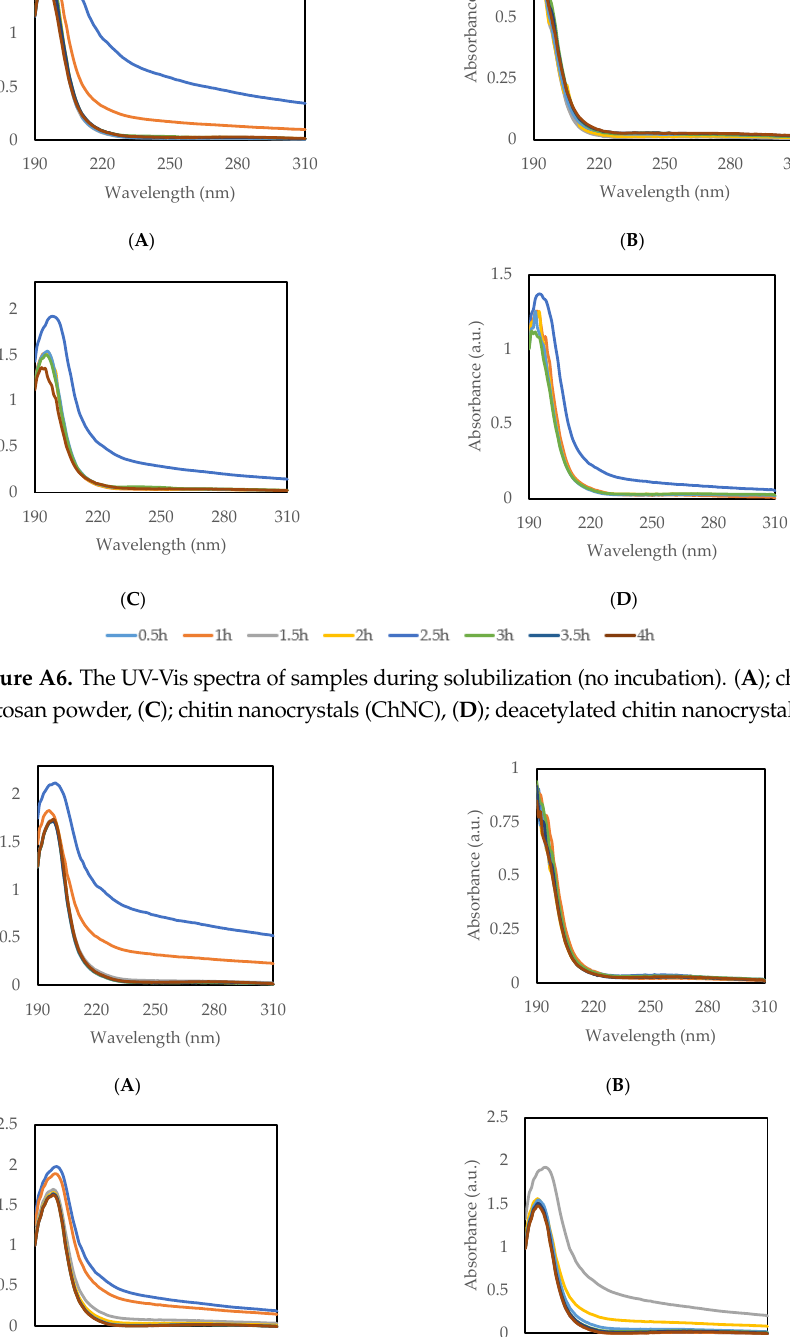
Figure A5. The measured DA of samples during solubilization (no incubation).